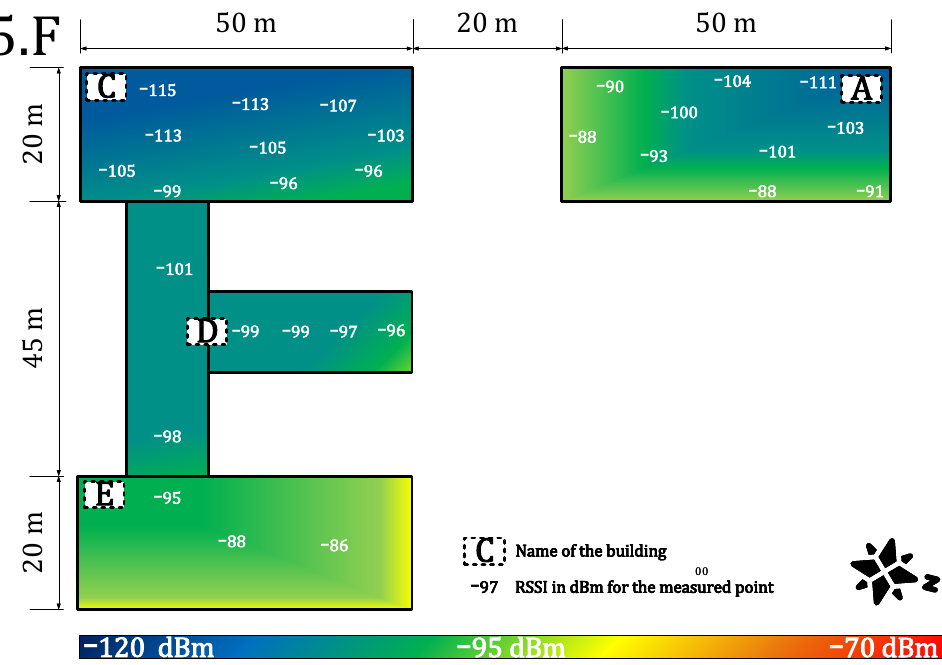
Figure 8. Public network coverage and signal propagation on the seventh floor.